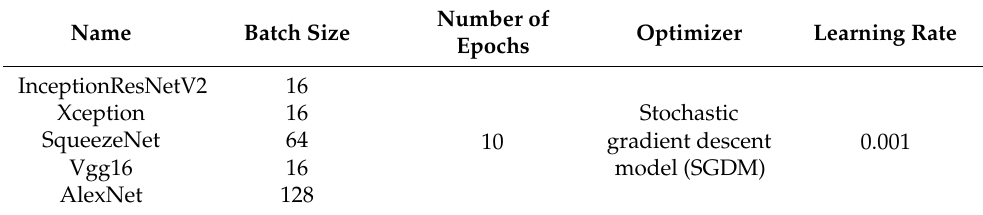
Table 3. Parameter configurations used in the training